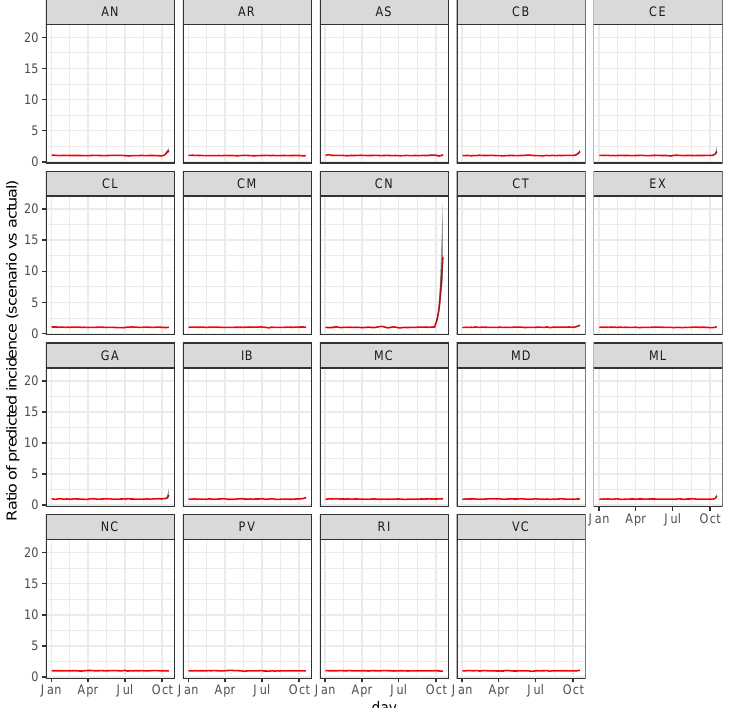
Figure A7. Effect on regions for a sudden increase of cases in the Canary Islands.The ratio between the predicted incidence for the scenario against the actually predicted incidence. Red is the ratio among medians along with 99% credible intervals (shaded grey